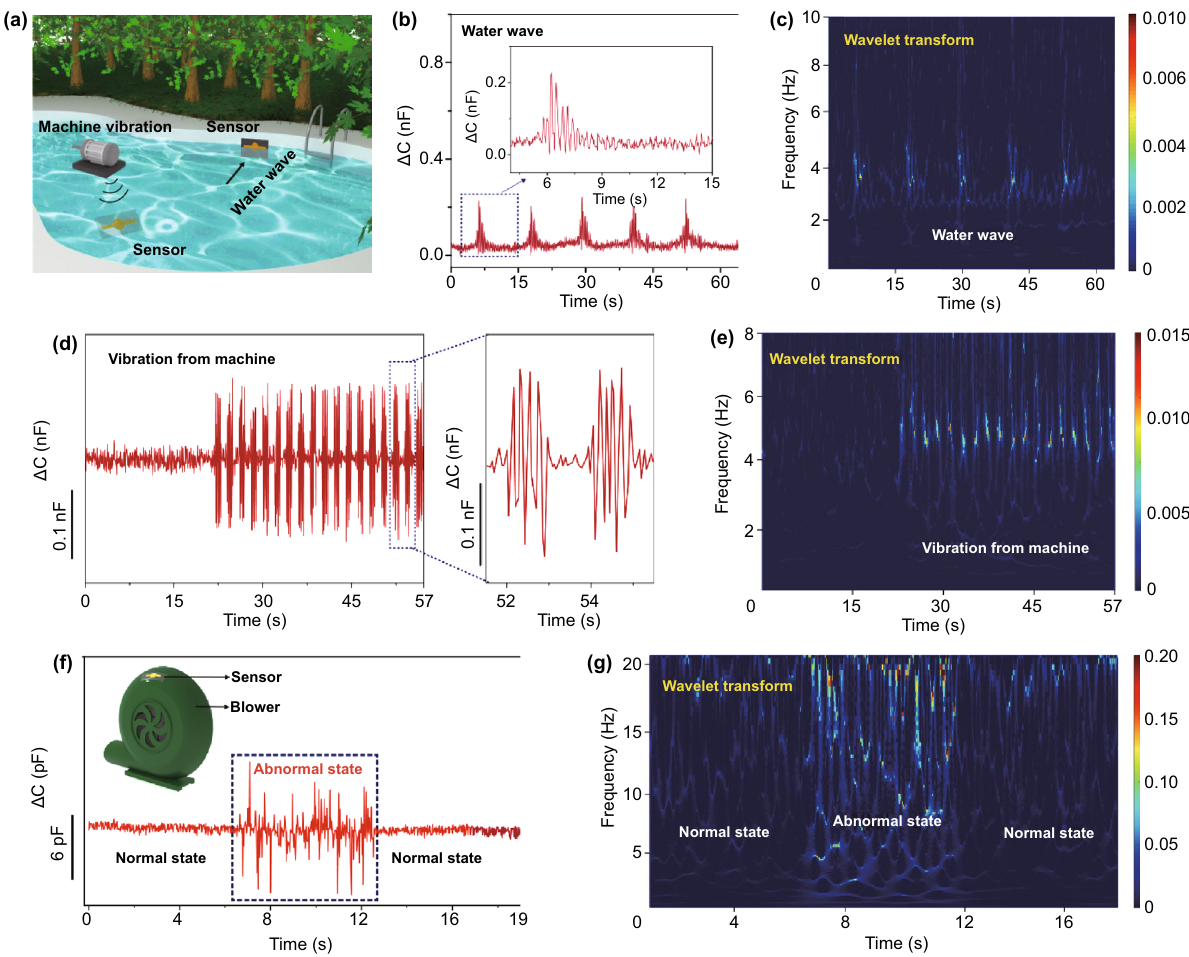
Fig. 5 Applications of the PU-IL foam-based pressure sensor. a Schematic illustration of the application scenarios of the sensor. b Waveform of water waves in time domain detected by using our pressure sensor, inset shows the waveform of a single wave envelope. c Frequency-time win- dow of water wave signals obtained by using wavelet transform. d Vibration signals of machine underwater detected by the sensor. e Frequency- time window of vibration signals from a machine underwater. f Capacitance signals of a sensor attached to a blower at normal and abnormal working conditions. g Frequency-time window of the blower at normal and abnormal working